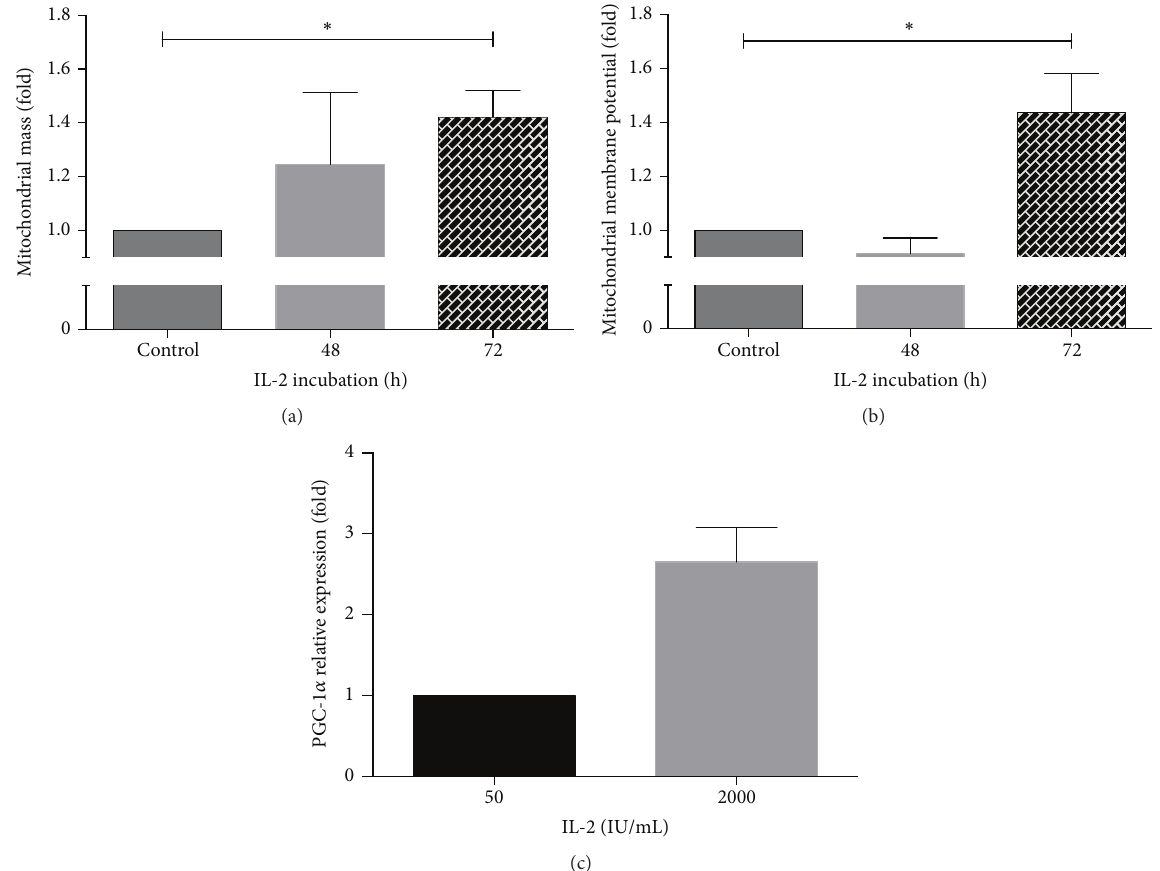
Figure 2: IL-2 induces an increase in mitochondrial mass, mitochondrial membrane potential, and PGC-1 𝛼 expression in human NK cells. NK cells were cultured in the presence of 50 IU/mL (control) or 2000 IU/mL IL-2 for 48 or 72 h and then analyzed by flow cytometry to measure mitochondrial mass (a) or mitochondrial membrane potential (b) as indicated in Materials and Methods. Data are shown as the mean of fluorescence intensity in cells and normalized against controls. Results are mean ± SE from 7 independent experiments ( ∗ 𝑝 < 0.05 ). (c) PGC-1 𝛼 mRNA expression was determined by qRT-PCR. Relative expression was normalized with control NK cells, and results show the mean of 5 independent experiments ± SE ( ∗ 𝑝 < 0.05